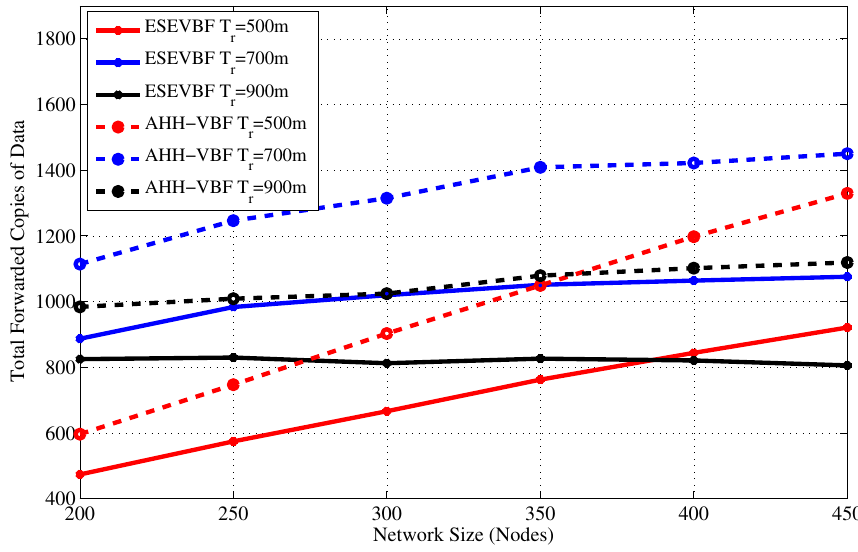
Figure 5. Number of data message copies forwarded in the network for different network size.